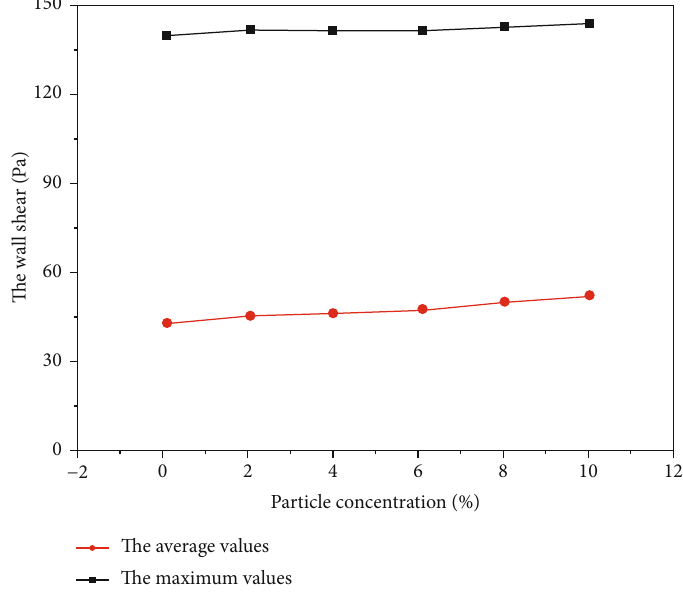
Figure 13: Variation of wall shear with particle